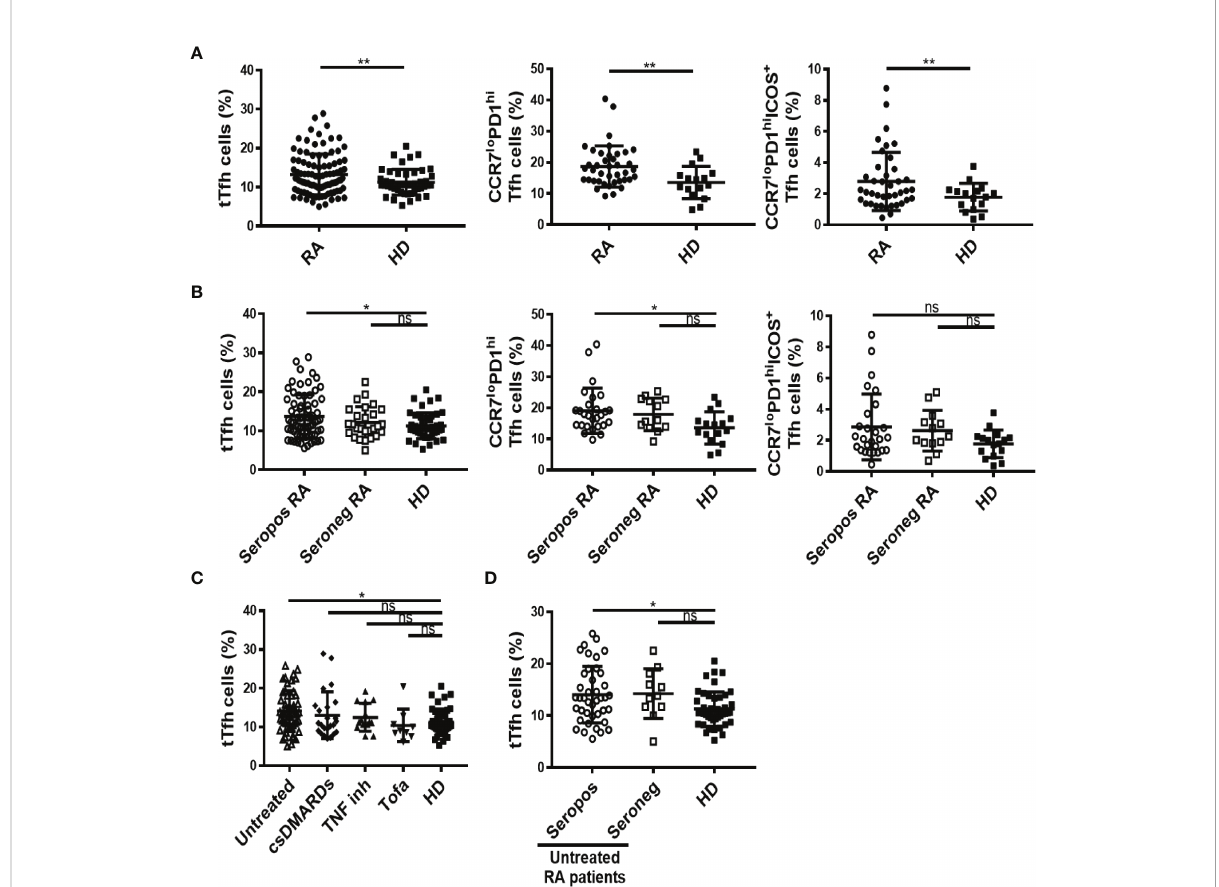
FIGURE 1 Frequency of total Tfh cells and different Tfh cell subsets in RA patients. (A) Frequency of CD25 lo CD127 hi total (t) Tfh cells (left), CCR7 lo PD1 hi Tfh cell subset (middle) and activated CCR7 lo PD1 hi ICOS + Tfh cell subset (right) in RA patients (n=99, 40 and 40, respectively) and HD (n=46, 16 and 16, respectively). (B) Frequency of tTfh cells in seropositive (Seropos, n=72) and seronegative (Seroneg, n=27) RA patients and HD (n=46) (left), frequency of CCR7 lo PD1 hi Tfh cell subset (middle) and activated CCR7 lo PD1 hi ICOS + Tfh cell subset (right) in seropositive (Seropos, n=27) and seronegative (Seroneg, n=13) RA patients and HD (n=16). (C) Frequency of tTfh cells in untreated (n=52), patients treated with different drugs: csDMARDs (n=24), TNF inhibitors (TNF inh, n=14), tofacitinib (Tofa, n=9), and HD (n=46). (D) Frequency of tTfh cells in Seropos (n=41), Seroneg (n=11) untreated RA patients and HD (n=46). Symbols represent individual subjects. Mean ± DS is shown. P values were determined by Welch- test or T-Test in (A) . One-way Analysis of Variance (ANOVA) followed by Bonferroni Multiple Comparisons Test were used in (B, D) and Kruskal- Wallis followed by Dunn ’ s Multiple Comparisons Test were used in (C) . Two-tailed probability, * p < 0.05 , ** p < 0.01 ; ns, not signi fi